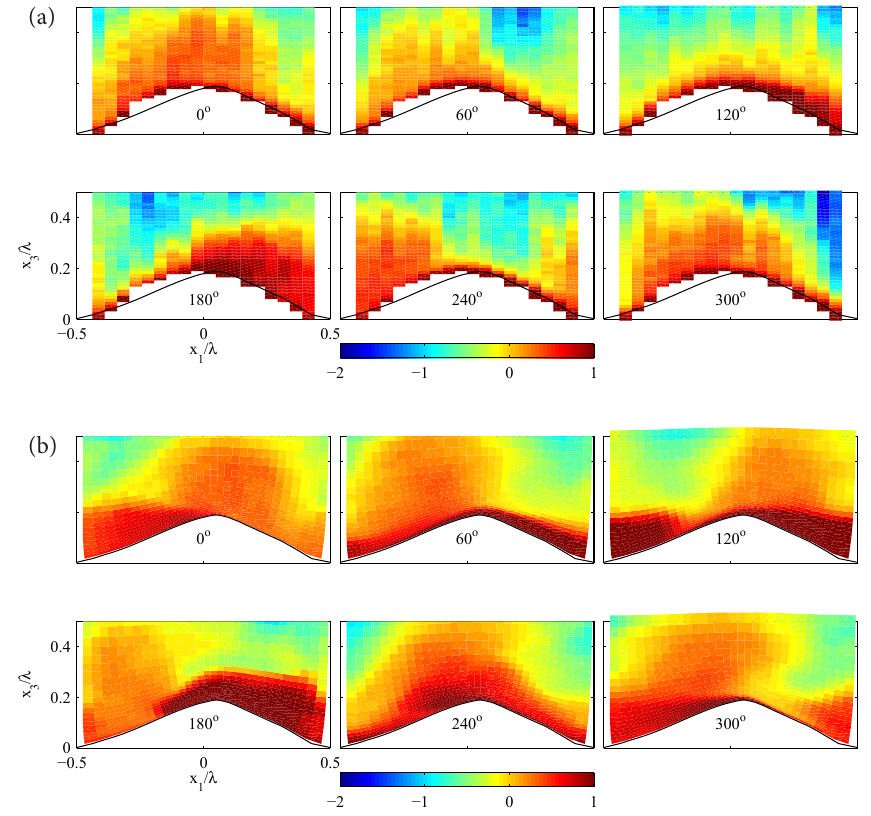
Figure 7. Suspended sediment concentration field (log 10 (C) , in gL − 1 ) for six different phases. (a) ABS measurements. (b) LES computa- tions assuming a surface roughness of z 0 = d 50 / 4.